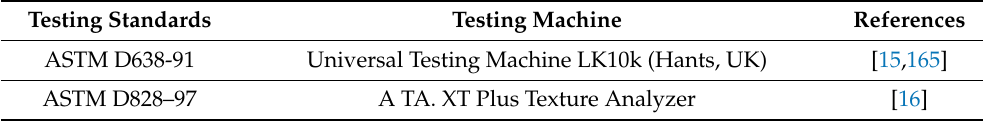
Table 3. Mechanical tests standards and the testing